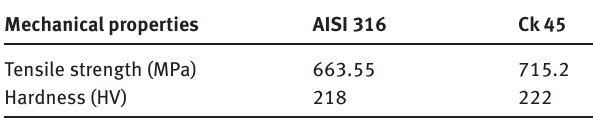
Table 2: Mechanical properties of the AISI 316 and Ck 45